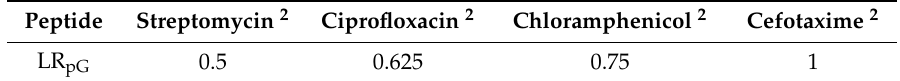
Table5. Thefractionalinhibitoryconcentrationindex(FICI) 1 forLR pG incombinationwithconventional antibiotics against E. coli